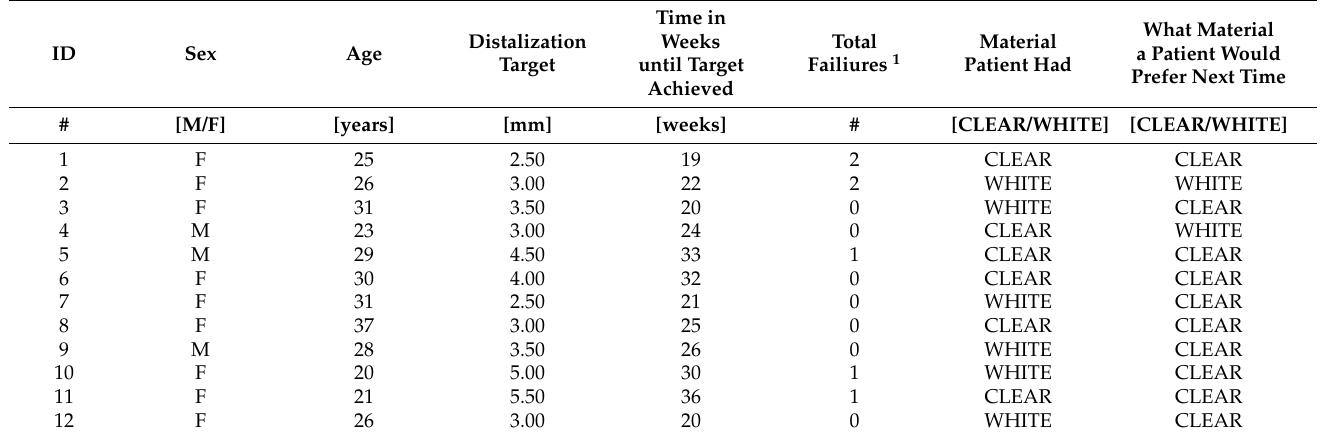
Table 4. Results of clinical evaluation for secondary objectives.